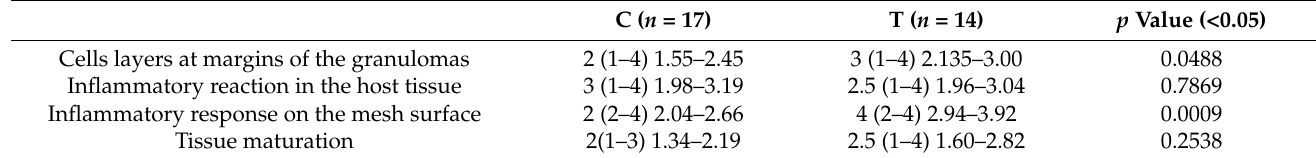
Table 1. Comparison of histological scores (Mann-Whitney test).